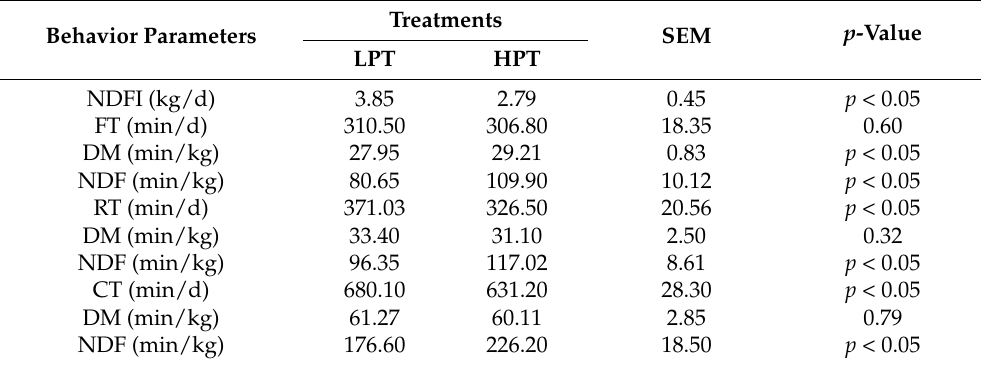
Table 5. Effects of low and high NFC to NDF ratio pelleted TMR on rumination behavior in Holstein growing cattle.